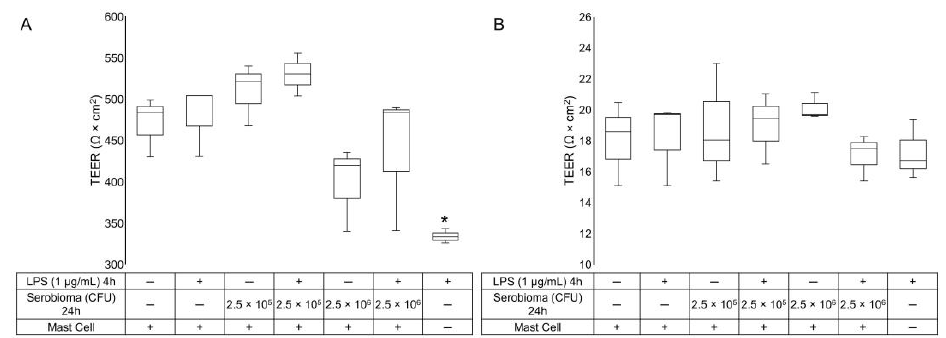
Figure 1. TEER measurement. ( A ) Caco-2/HT-29 co-culture and ( B ) HT-29 confluent cells were challenged with LPS for 4 h and then treated with the probiotic mixture for a further 24 h in the presence of HMC-1.2, in the basolateral compartment. Statistical analysis: one-way ANOVA followed by Dunnett’s post hoc, * p -value < 0.05 ( n = 3).